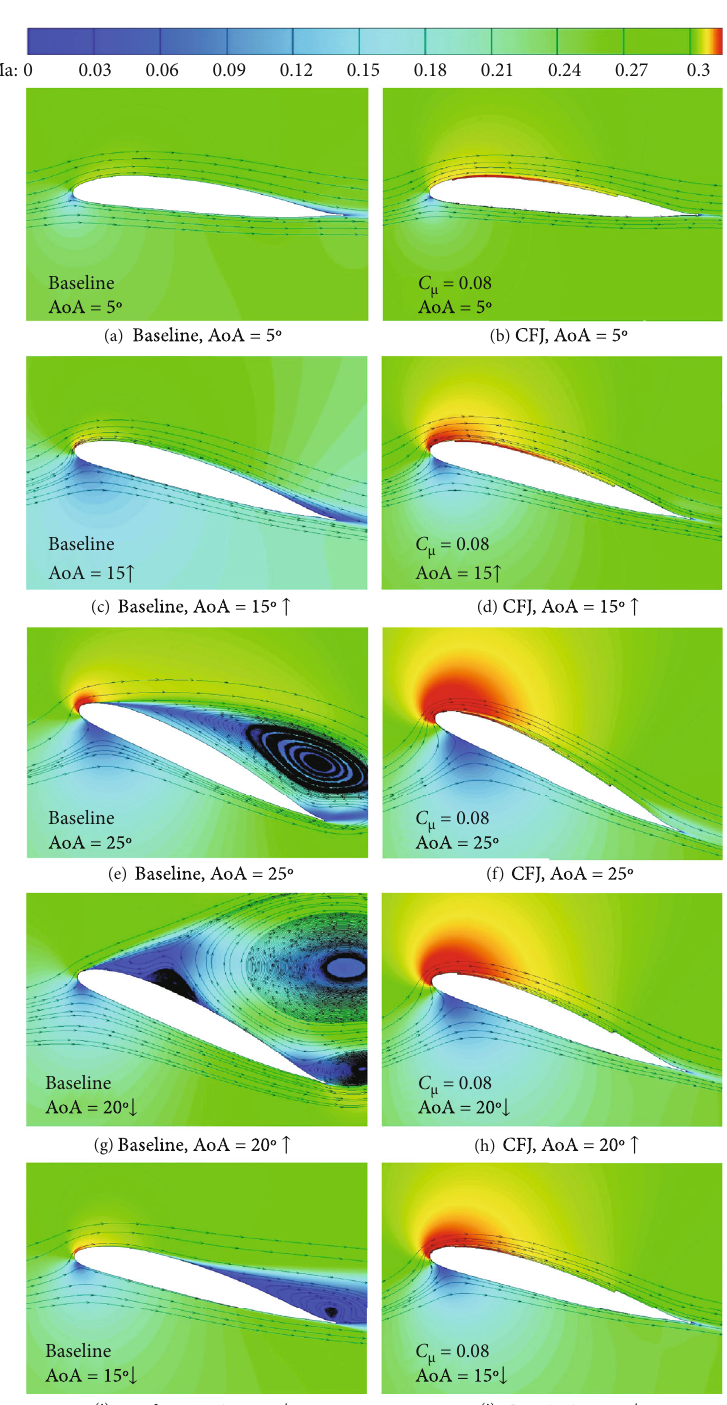
Figure 8: Comparison between the fl ow fi elds of the OA212 baseline and CFJ airfoils at di ff erent